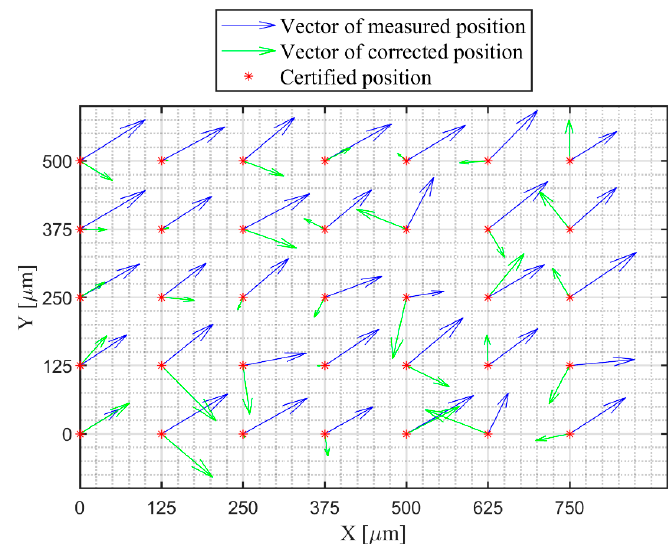
Figure 23. Comparison of the error vectors between the measured and corrected points of Simulation No. 10.